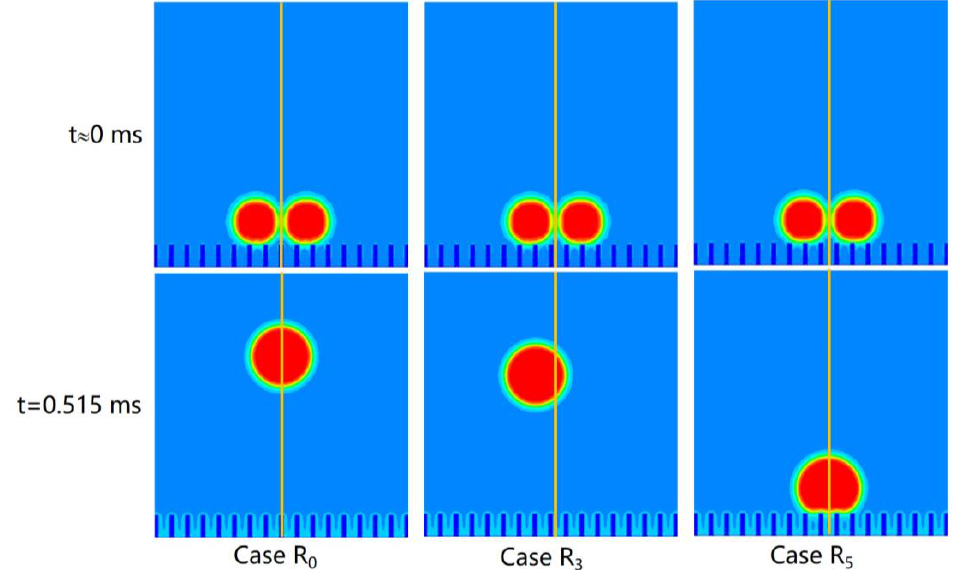
Figure 4. Simulation results with initial representative positions (the subscript j of Case R j indicates the position of the mutual tangent of two droplets).